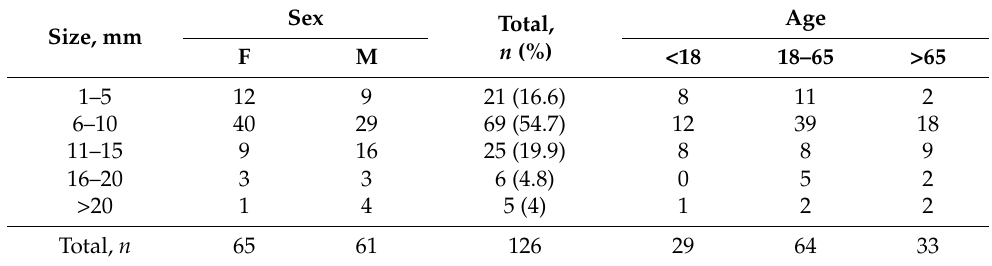
Table 6. Lesion size* by sex and age ( n = 126).